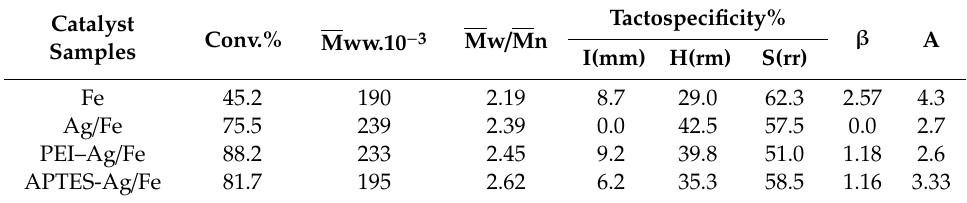
Table 3. Results of methyl methacrylate solution polymerization at 80 ◦ C for 3 h in an oxygen table shows the conversion%, the molecular weight distribution, and 1 HNMR results of